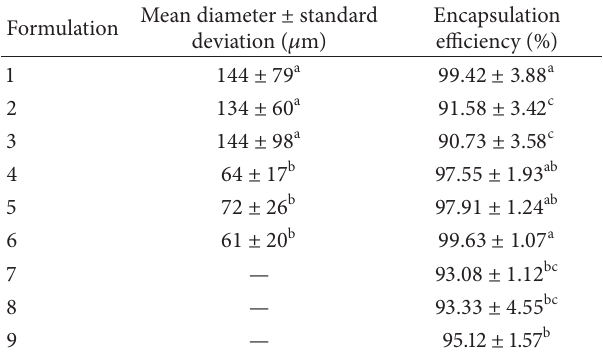
Table 2: Mean diameter of formulation 6 moist microcapsules, lyophilized and rehydrated by different